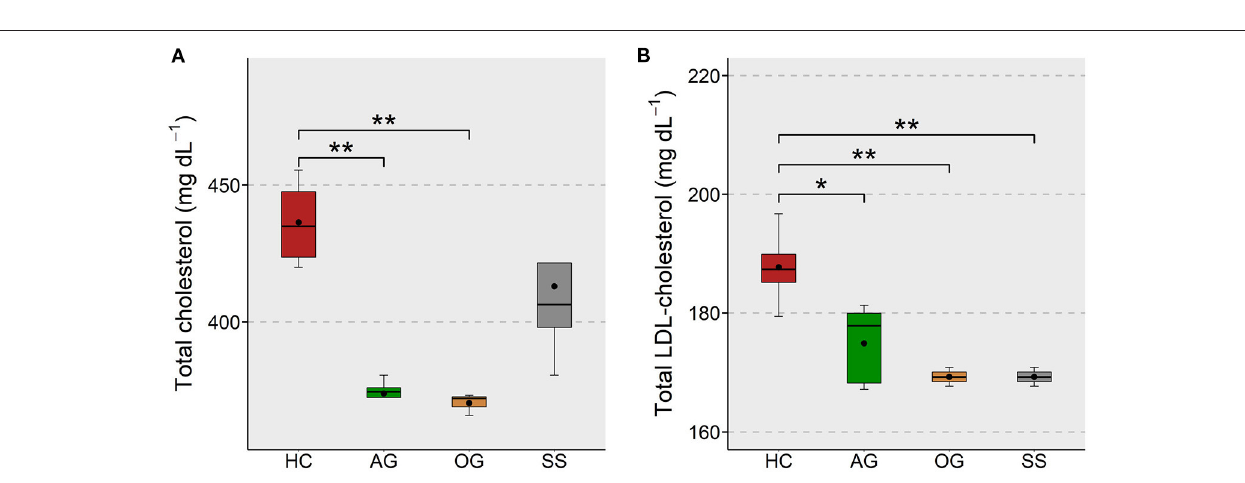
FIGURE 2 | Total and LDL-cholesterol levels in the plasma of zebrafish fed glucans or simvastatin. Boxplots show total cholesterol (A) and LDL-cholesterol (B) levels (mg dL − 1 ) in the plasma of zebrafish fed high cholesterol (HC) diet or HC diet supplemented with either algal glucan (AG) or oat glucan (OG) or simvastatin (SS), for a period of 12 weeks. Black dots inside each box indicate the mean values of the corresponding groups. ** indicates p < 0.01 and * indicates p <